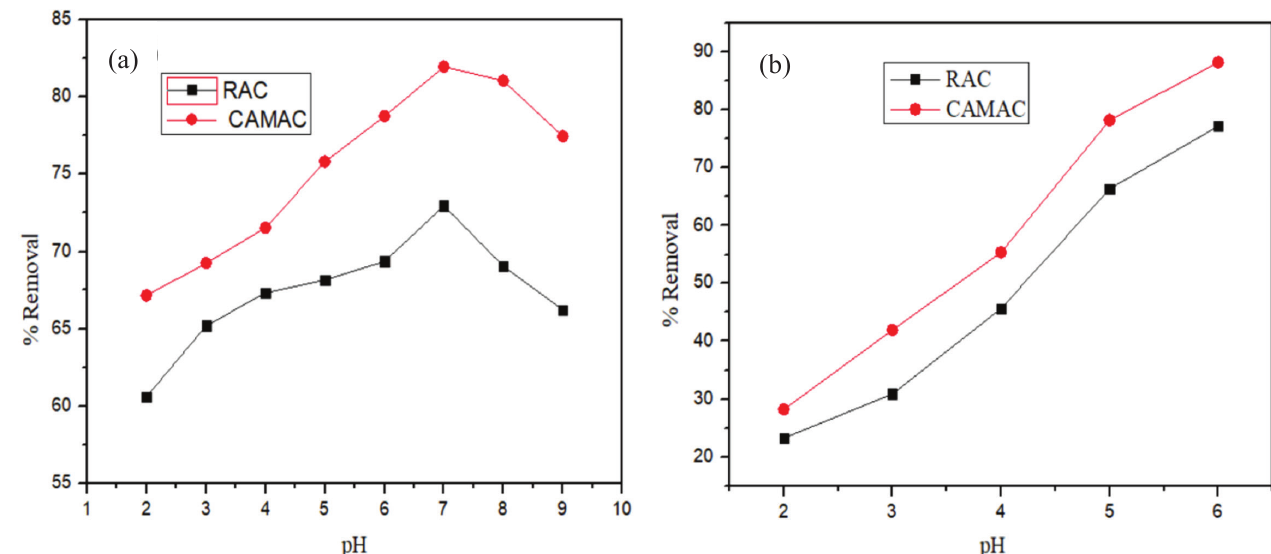
Fig. 6 – Effect of pH on adsorption of As(III) (a) and Cu(II) (b) onto RAC and